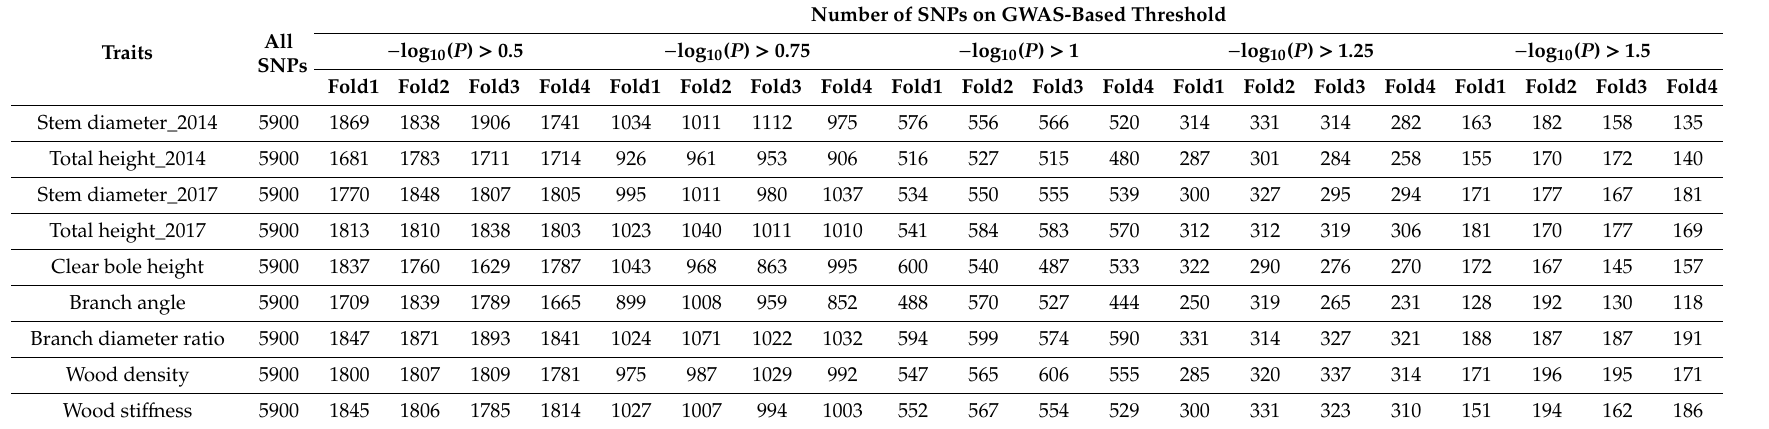
Table 1. Numbers of significant SNPs detected and applied in four-fold cross-validation for indicated growth, branch and wood quality traits of Shorea platyclados population with indicated Genome-Wide Association Studies (GWAS)-based thresholds.